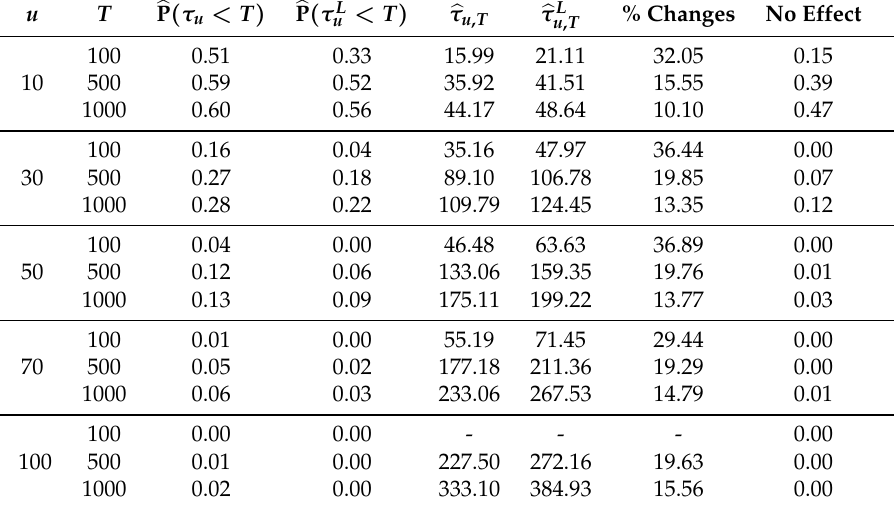
Table 6. EOL reinsurance for IG ( 2,1.5 ) distributed claims. The safety loading is θ = 0.1, expected claim size is µ = 2, claim arrival rate is λ = 1, and each time unit is 0.01 years. Simulations are done with N = 100,000 sample paths. Retention level L is the solution to (17). For T = 100, L ( T ) = 6.89;